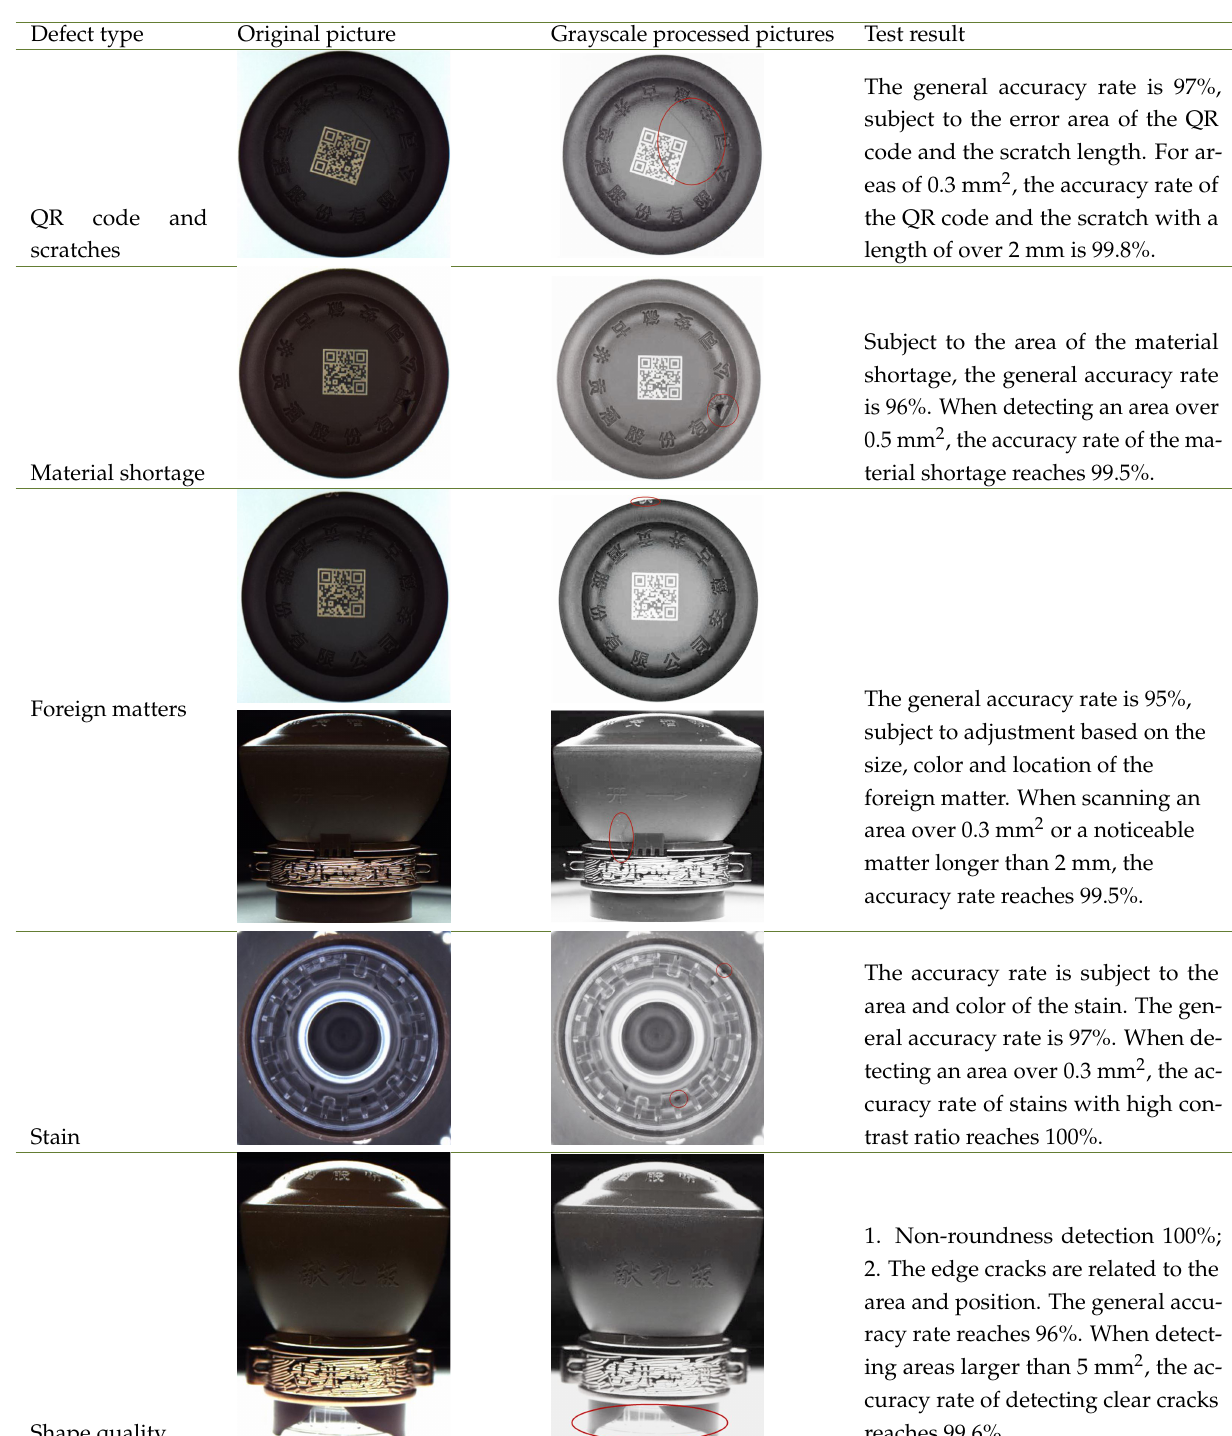
Table 3. The test results of the system